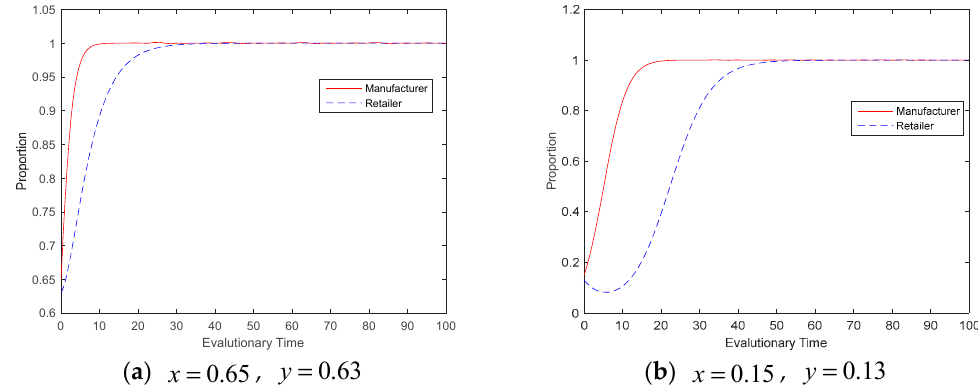
(1,1) E . Figure 5. The Evolution Process of Evolutionary Stable Strategy of E ( 1,1 ) 4 4